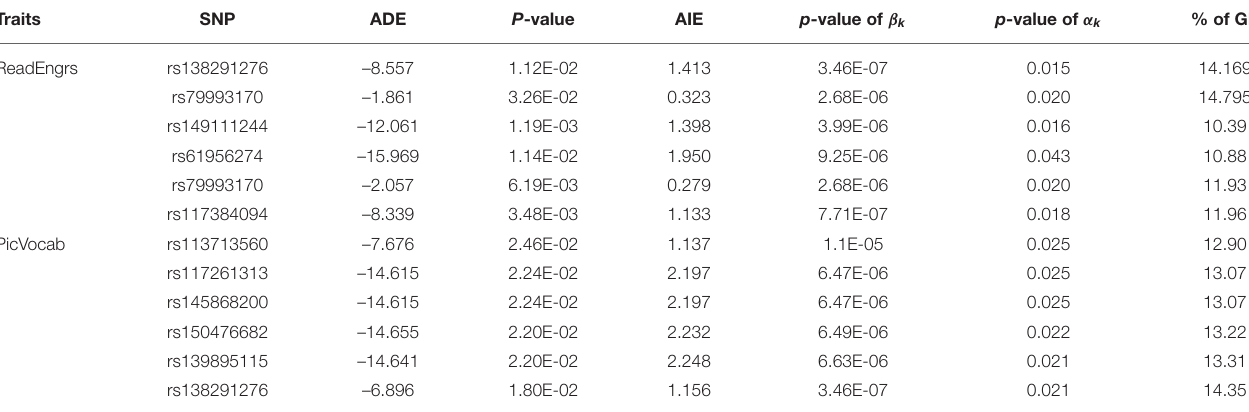
TABLE 2 | Average direct effect (ADE) and average indirect effect (AIE) are shown. Traits SNP ADE P -value AIE p -value of β k p -value of α k % of GE